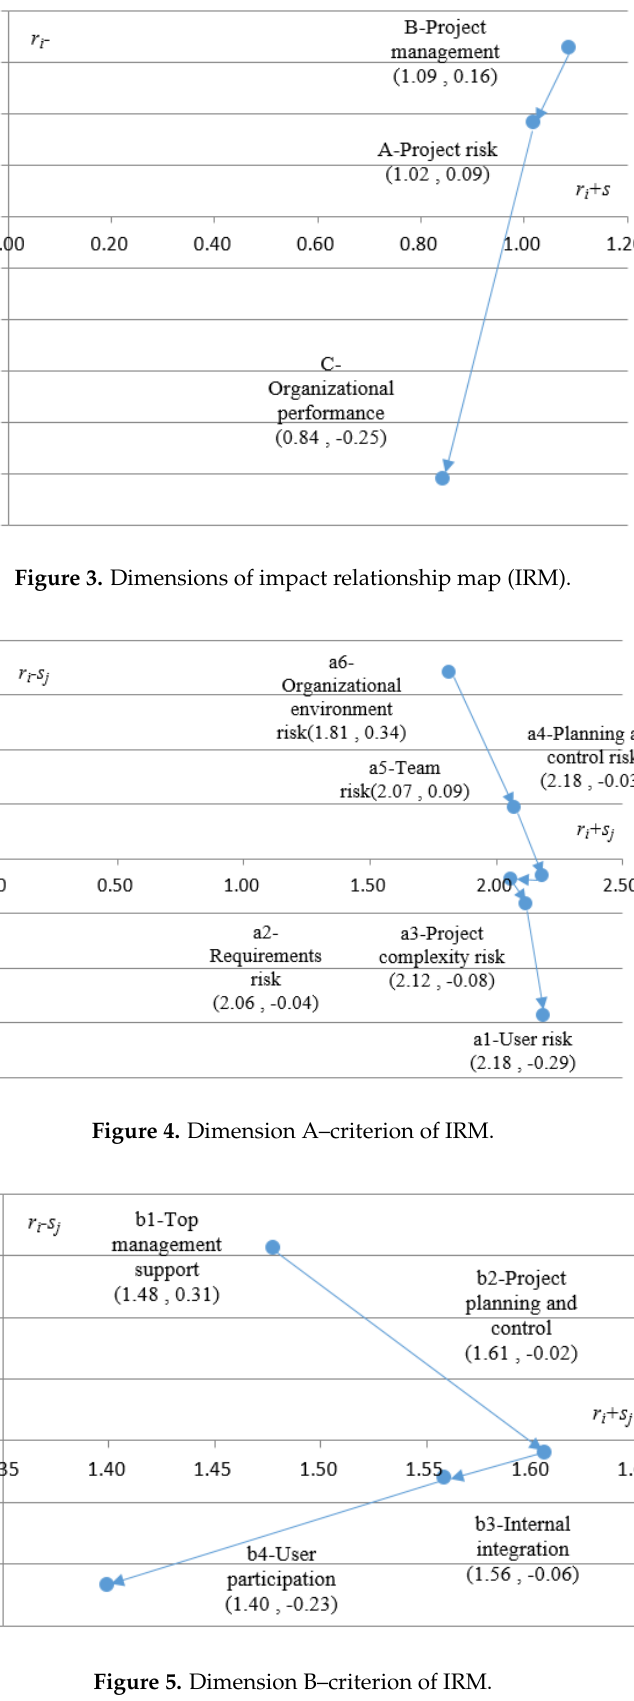
Figure 6. Dimension C–criterion of IRM. 4.2. Calculating Criterion Weights Using ANP In the ANP technique processing, Procedures 4 to 6 were executed accordingly. (1) In Procedures 4 and 5, the total criteria relationship matrix and total dimension relationship matrix were normalized